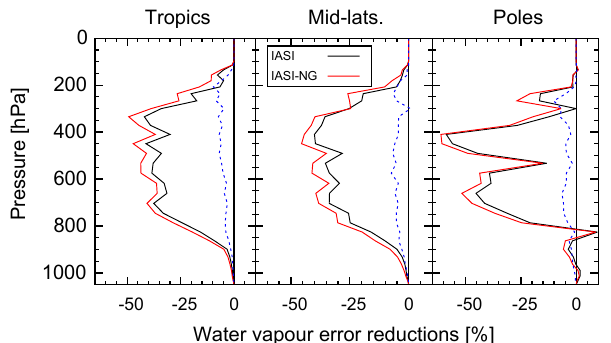
Figure 11. Error reduction ( σ reduction ) in percentage for water vapour with the assimilation of the 123 channels for IASI (black line) and IASI-NG (red line) with respect to regional areas (tropics, mid-latitudes and polar regions). The blue dashed line corresponds to the difference of error reduction between IASI-NG and IASI as-